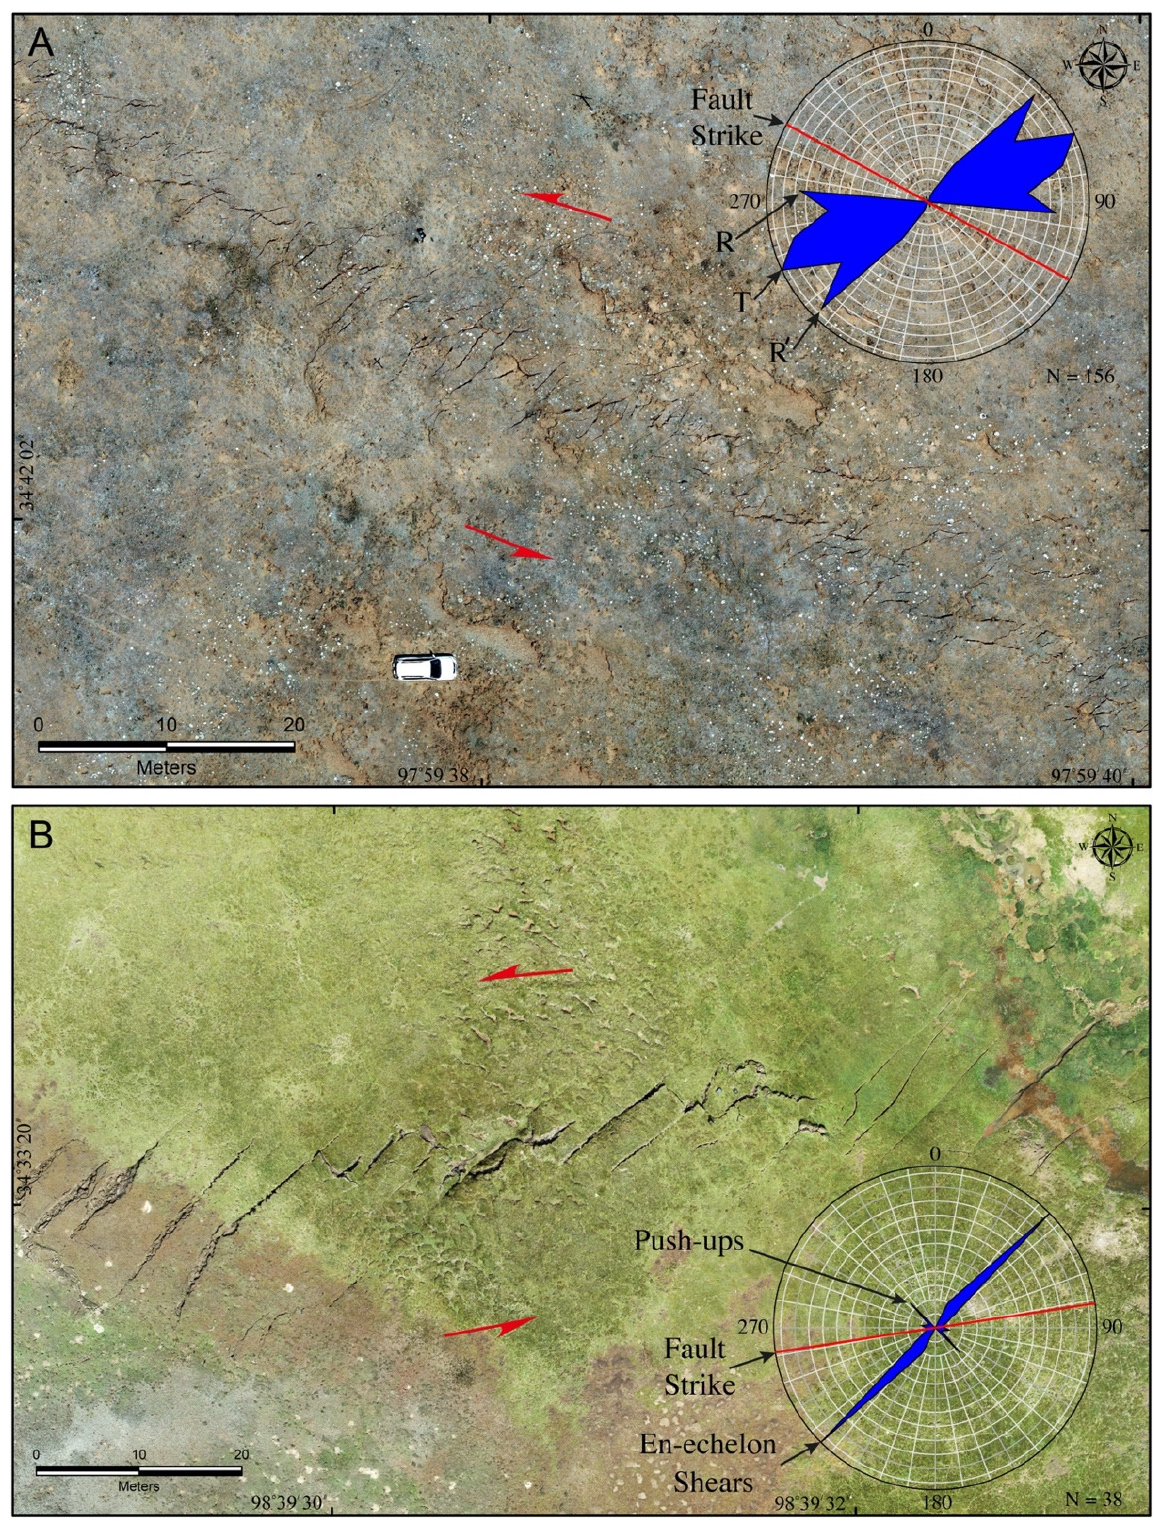
Figure 5. Orthophotos of the surface rupture and fracture distribution statistics. ( A ) R shears, R ′ shears, and T fractures are major fractures. ( B ) En-echelon shears and push-ups are major structures.